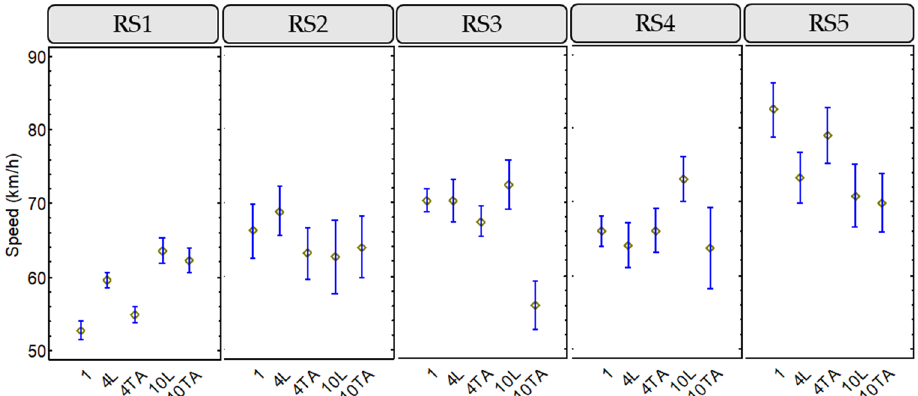
Figure 7. Means and 95% LSD intervals for overtaking speed, considering road segment and peloton configuration.